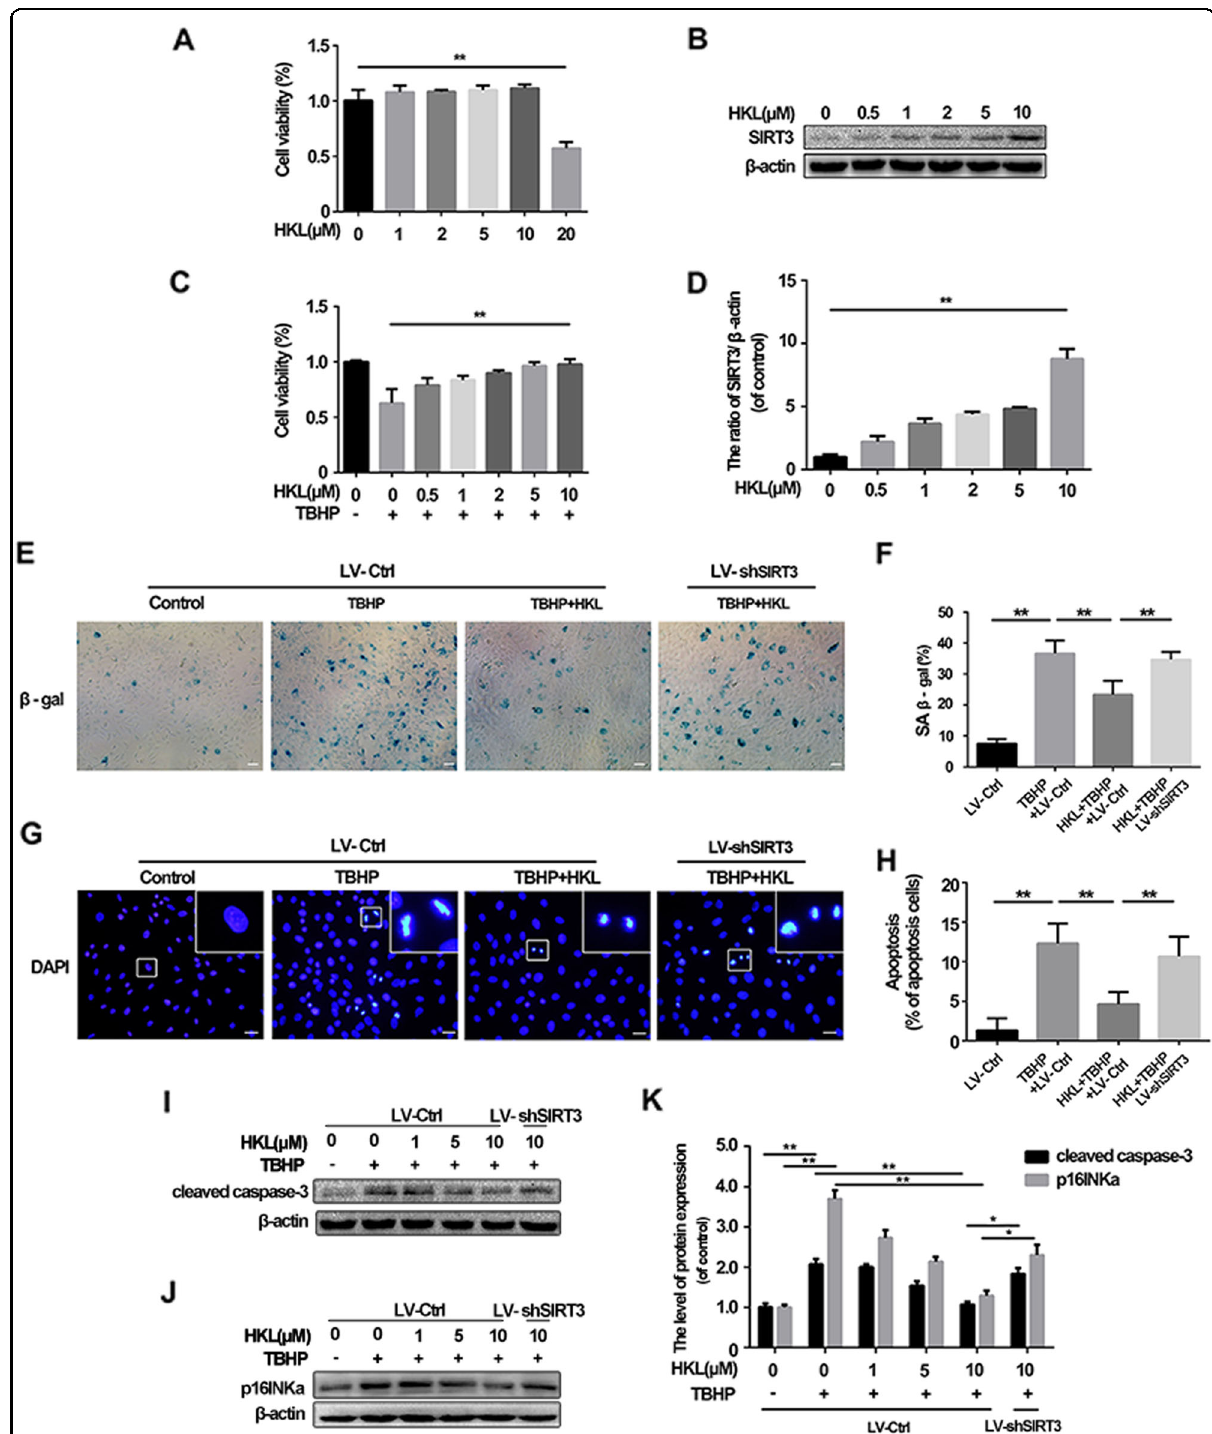
Fig. 3 HKL suppresses apoptosis and senescence induced by TBHP by activating SIRT3 in rat NPCs. a NPCs were treated with different doses of HKL for 24 h. b, c NPCs were treated with different doses of HKL as indicated. Cell lysate was harvested and analyzed for the expression of SIRT3 using Western blots. d NPCs, pretreated with different doses of HKL, were administered with TBHP. e, f SIRT3 knockdown inhibited the capacity of the anti-senescence of HKL in NPCs. Scale bar 100 μ M. g, h Fluorescence microscopy of Hoechst 33342 staining for morphological assessment of apoptosis. Apoptotic nuclei were characterized by condensed chromatin and nucleus fragmentation. Scale bar, 50 μ M. i – k The expressions of cleaved caspase-3 and p16INKa were detected by western blotting. All experiments were performed in duplicate, and data are reported as the mean ± SD. * P < 0.05, ** P <